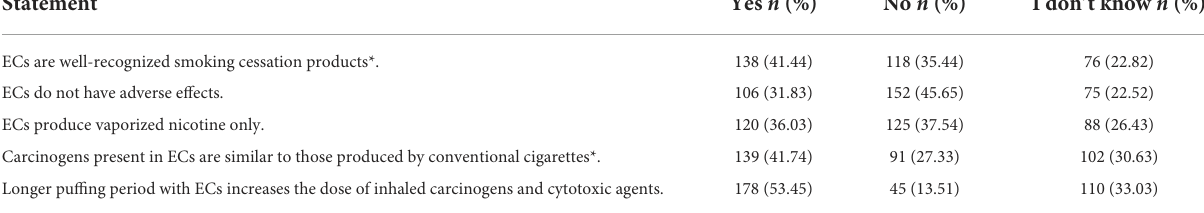
TABLE 2 Health care students’ knowledge toward e-cigarettes. Statement